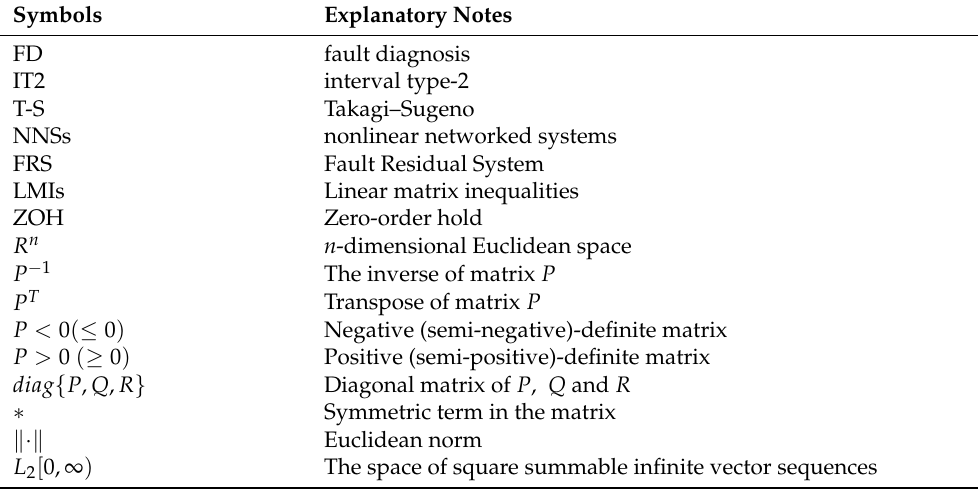
Table 1. Explanation of abbreviations and